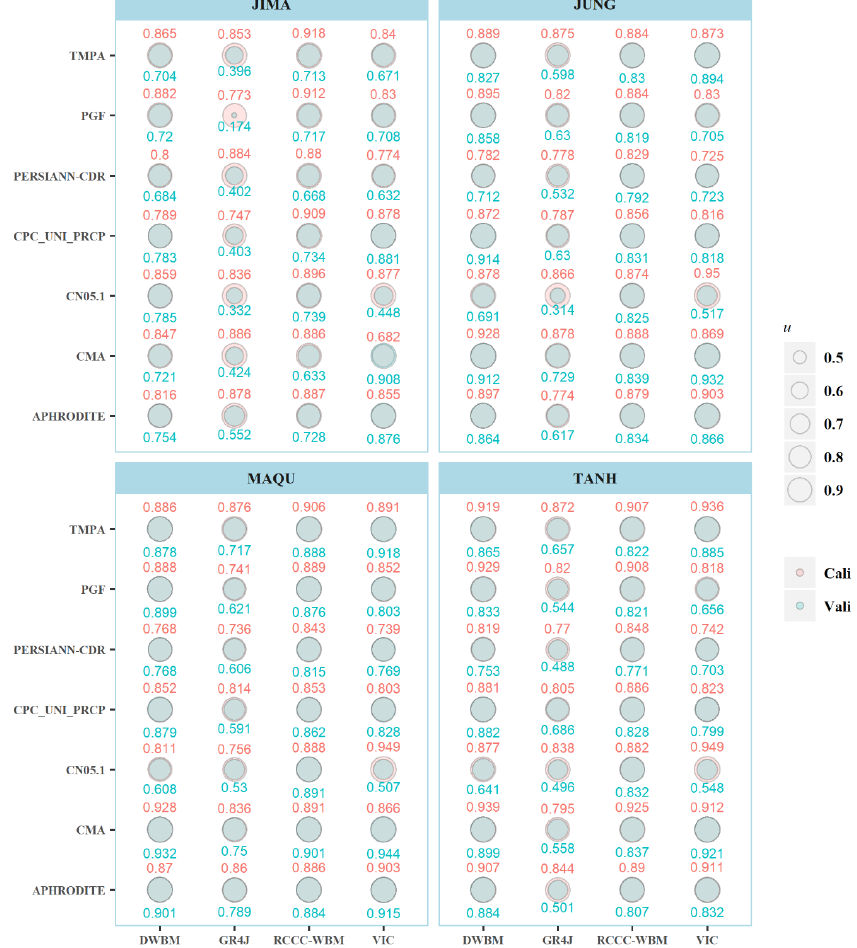
Figure 10. Relative membership degree ( u ) of different precipitation products at 4 stations by 4 hydrological models, where the red and cyan numbers above and below the bubble points indicate the u values at the calibration (Cali, 1998–2008) and validation (Vali, 2009–2014) period, respectively. It could be seen that the two hydrological models (DWBM and RCCC-WBM), when modeling the runoff process at a monthly scale, obtained more stable and higher u values than the GR4J (daily conceptual model) and VIC models. The difference in precipitation estimates from various precipitation datasets had more influence in the GR4J and VIC models. In most scenarios, the RCCC- WBM performed best in streamflow simulation with diverse precipitation estimates sources. For the RCCC-WBM model, the u values were around 0.9 in the calibration period and 0.8 in the validation period. As for the GR4J model, the u values dropped a lot at the validation period, compared to that in the calibration period, especially at the JIMA station. Even in the calibration period, the u values obtained in the GR4J model were generally lower than those obtained by three other models, which all indicated the less suitability and high uncertainty of the GR4J model, coupled with snowmelt module in streamflow process simulation, based on the SDFE or RA precipitation datasets in the